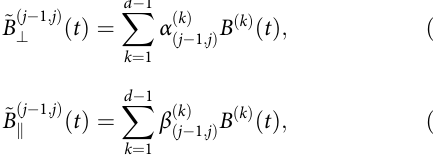
states. The noise participation ratios α ð k Þ